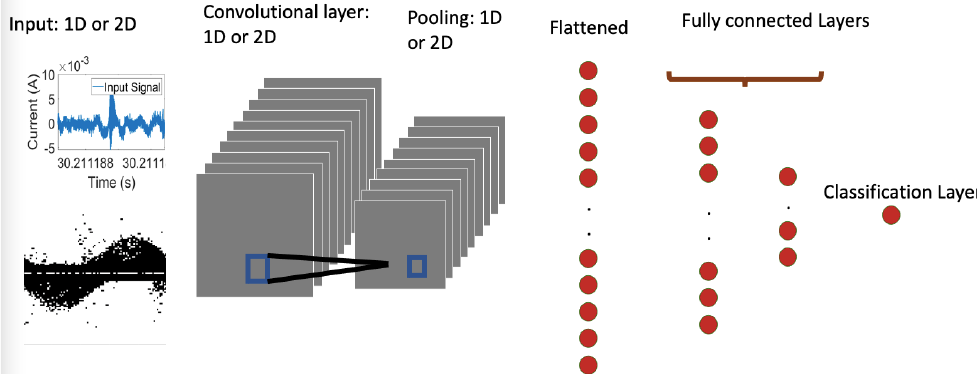
Figure 4. A simple CNN architecture: a convolutional layer, pooling layer, fully connected layers followed by the classification